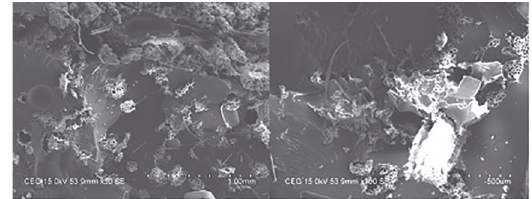
Figure 18: SEM micrographs of carbon/banana fiber composites subjected to tensile loading